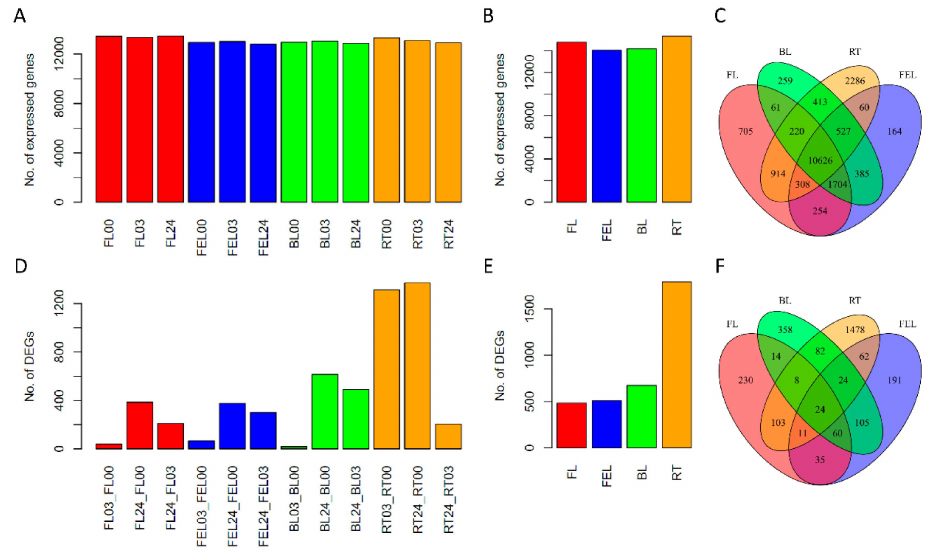
Figure 2. Transcriptome profiling of cassava in response to PEG stress. Expressed genes identified in 12 samples ( A ); four tissues ( B ) and their Venn diagrams ( C ); respectively; differentially expressed (DE) genes identified in 12 samples ( D ); four tissues ( E ); and their Venn diagrams ( F ), respectively. FL: folded leaf; FEL: full expanded leaf; BL: bottom leaf; RT: root. The numbers attached behind leaf samples represent the time point at which samples were collected: e.g., 00, 03, and 24 represent 0, 3, and 24 h,